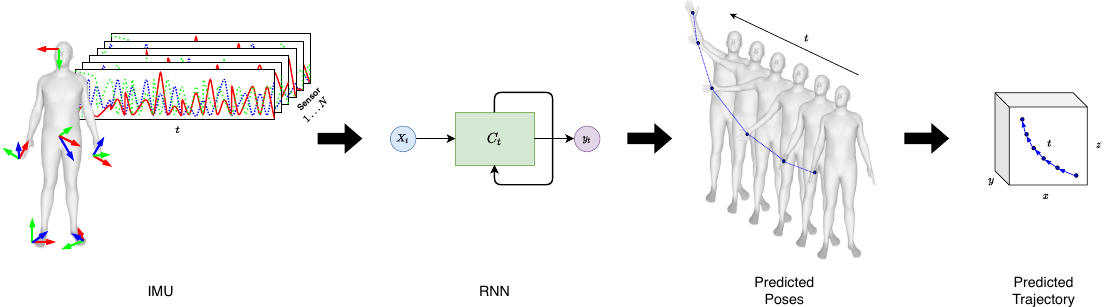
Figure 3. Overview: Left: IMU signals from sensors placed on a human body. Middle: a RNN takes the IMU signals as input and predicts a full body pose from only 6 sensors. Right: the algorithm allows selective tracking for each body part; hence it allows a point-wise trajectory generation.